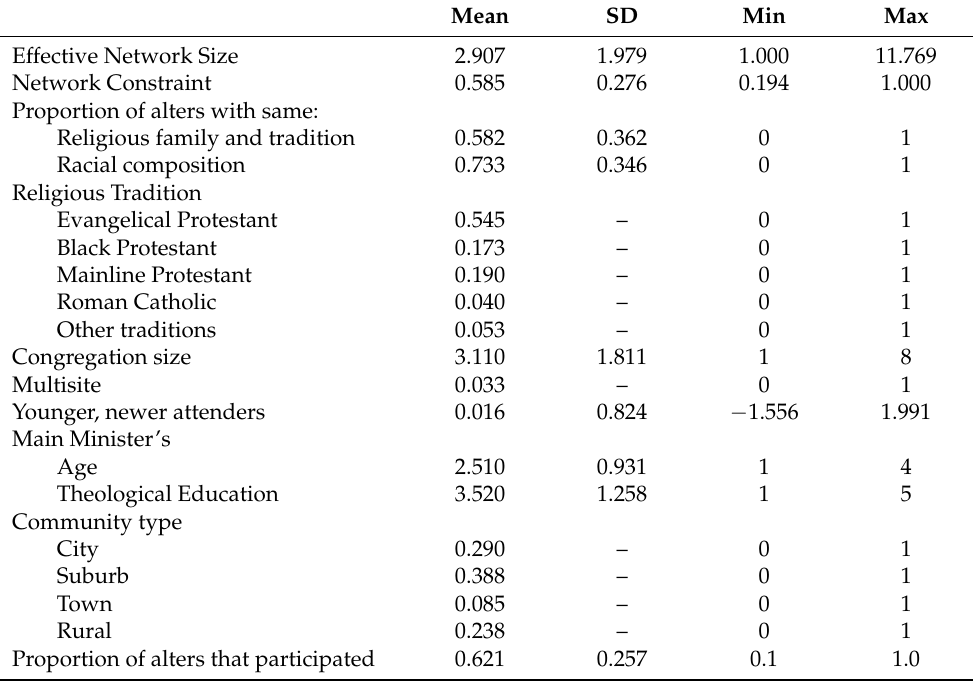
Table 1. Descriptive